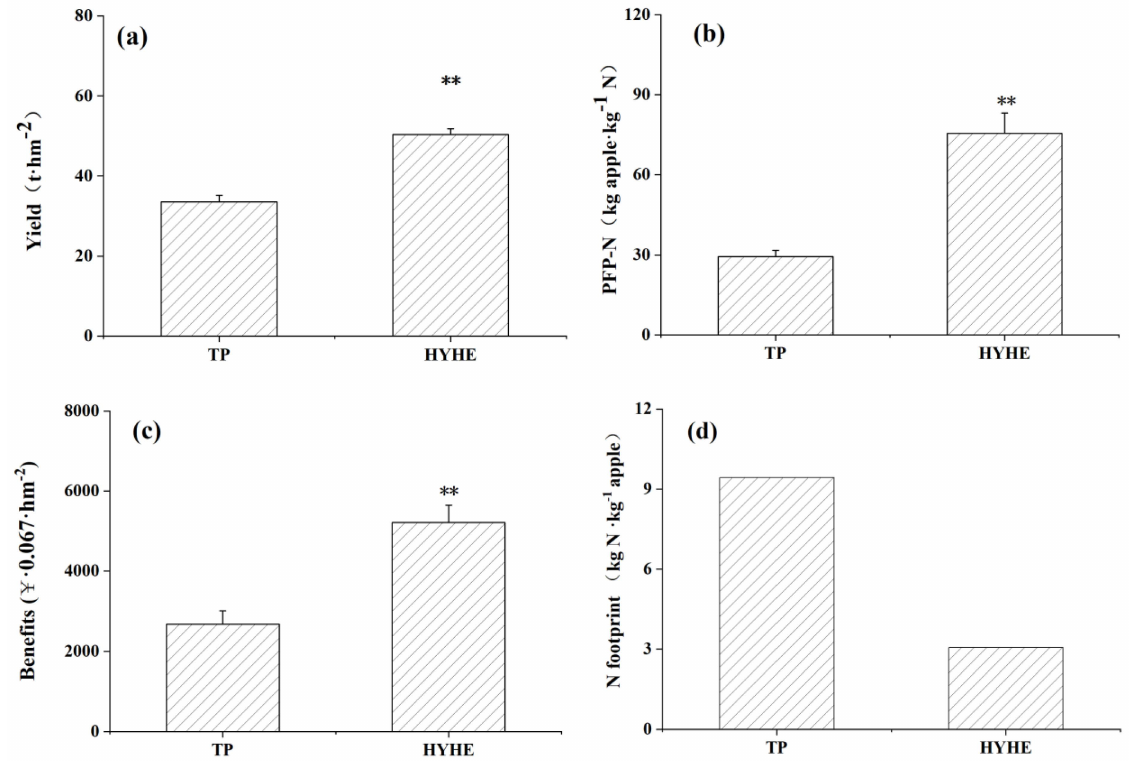
Figure 3. Comparison of indicators between traditional producers (TP) and high-yield high-efficiency (HYHE) farmers. ( a ) Yield, ( b ) PFP-N, ( c ) economic benefits, and ( d ) N footprint. ** p <